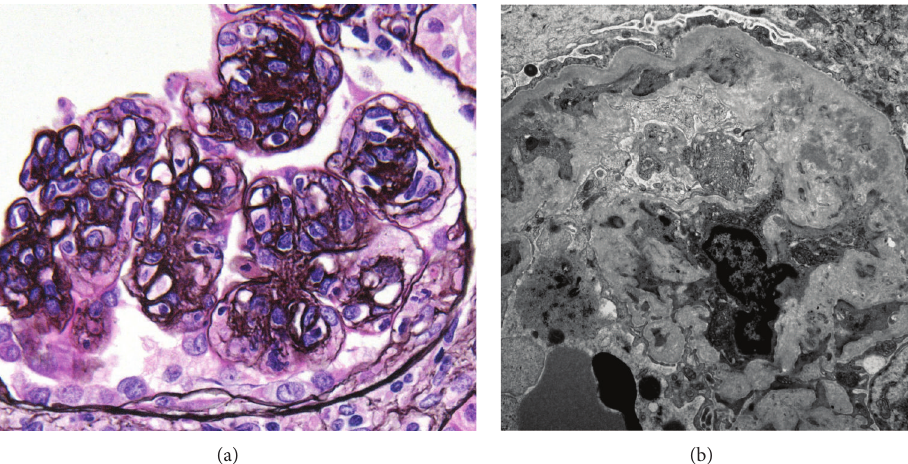
Figure 2: Glomerular features of second renal biopsy. (a) Lobular hypercellular glomerulus with capillary wall double contours (periodic acid methenamine silver × 600). (b) Capillary wall with subendothelial deposits and peripheral mesangial migration and interposition producing a double contour ( ×